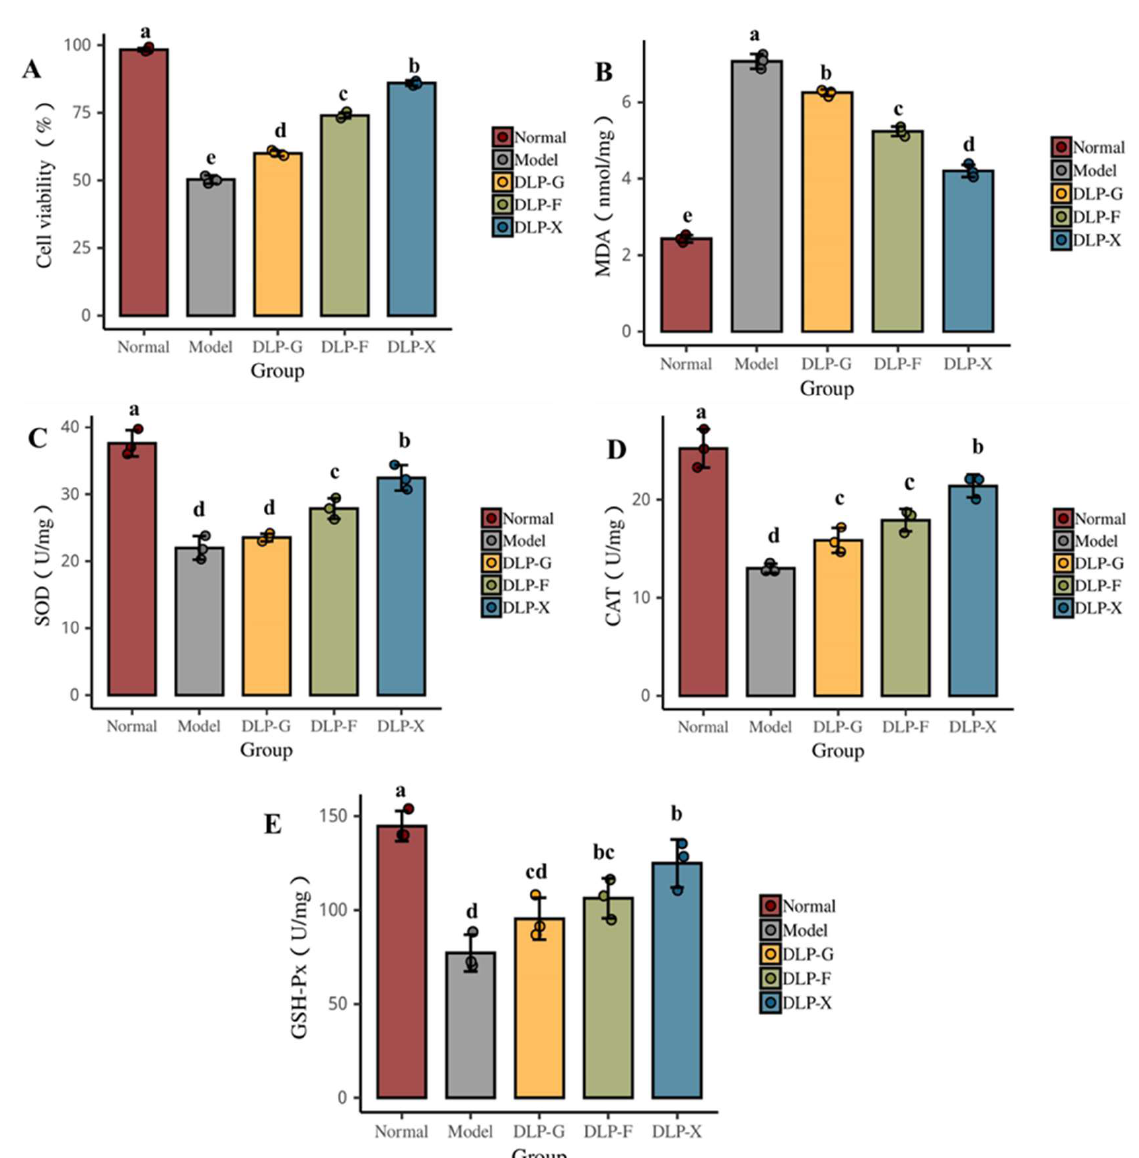
Figure 3. Effect of different glycosyl donor duck liver protein glycosylation products on protection against oxidative damage in HepG2 cells. ( A ) shows the effect of the glycosylated products of duck liver protein using glucose, fructose, and xylose on the survival rate of HepG2 cells, while (B– E ) show the effect of the glycosylated products of duck liver protein using glucose, fructose, and xylose on the activity of oxidative stress factors MDA, SOD, CAT, and GSH-Px in HepG2 cells, respectively) (Note: Different letters indicate that the samples are significantly different at α = 0.05